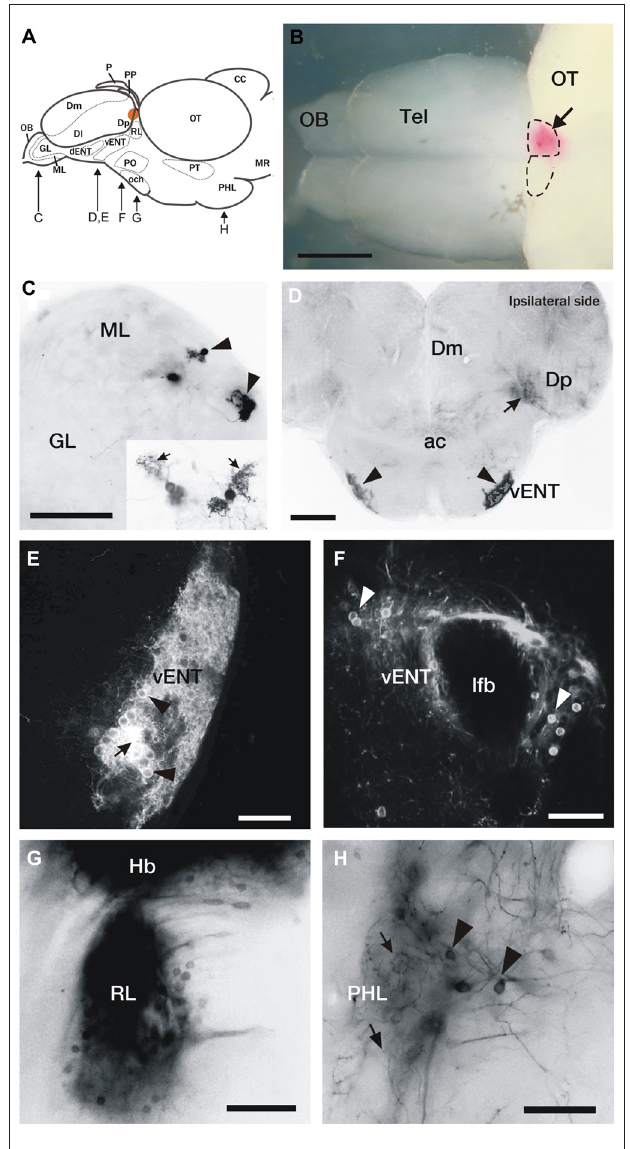
FIGURE 1 | DiI labeling of connections of the habenula in adult zebrafish. (A) Brain schematic showing the levels of sections in (C–H) . Images are dorsal view of whole brain with anterior to the left (B) or transverse sections (C–H) through the brain of adult zebrafish after DiI application to the left or right habenula (orange area in A and pink in B ). (B) Location of a typical DiI application into the right habenula (arrow). Dotted lines mark the limits of both habenulae. (C) Labeled mitral cells located in the dorsomedial region of the mitral cell layer in the olfactory bulb (arrowheads). Level of this section corresponds to Figure 2A . Inset: Detail of two mitral cells, showing characteristic dendritic arbors (arrows). (D) Labeled cells located bilaterally in the ventrolateral telencephalon (vENT, arrowheads) and neuropil formed by mitral cell collaterals in Dp (arrow). Note that although the vENT is labeled bilaterally, the ipsilateral nucleus (right) is more intensely labeled. Level of this section corresponds to Figure 2C . (E,F) Confocal images of the cells located in the vENT. At rostral levels (E) , small neuronal cell bodies (arrowheads) are densely distributed among a dense network of cell processes (arrow; this level of the nucleus corresponds to Figure 2C ). At caudal levels (F) , more sparsely distributed neurons (arrowheads) surround the lateral forebrain bundle (this level of the nucleus corresponds to Figure 2D ). (G) Labeled cells in a ( Continued